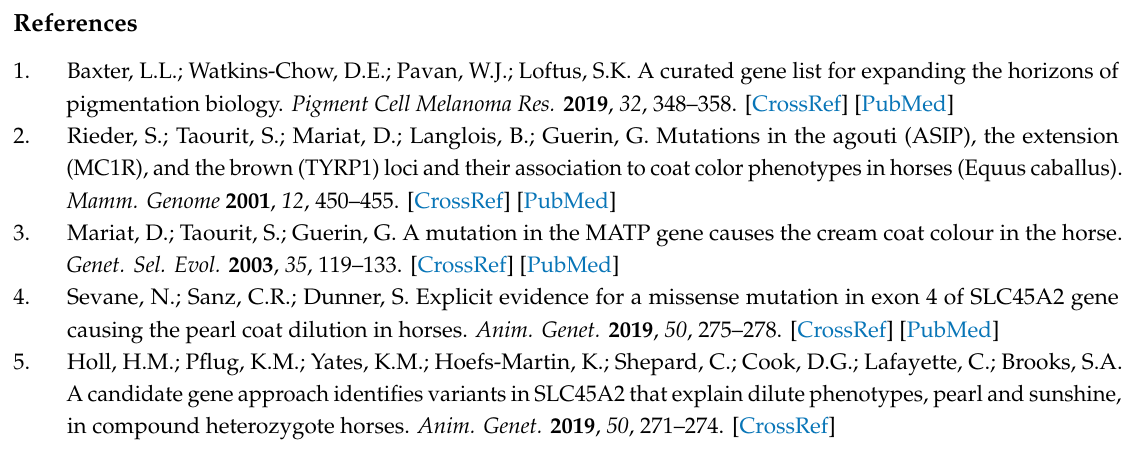
Figure S1: Investigating Genomic Inflation in the GWAS Sample Set. Identity by descent and Population structure, Figure S2: Regression Coe ffi cient Plots, Table S1: Primer sequences for eight top prioritized GWAS